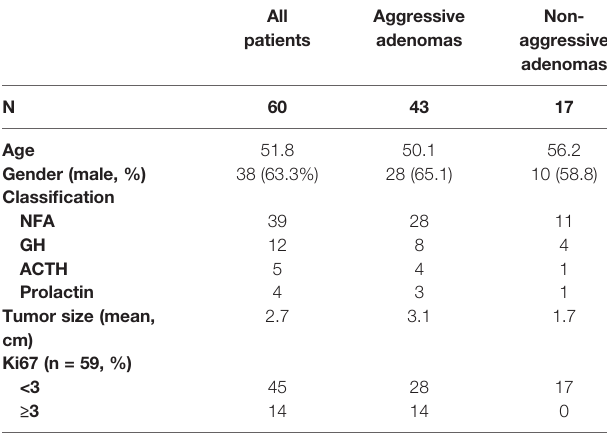
TABLE 1 | Clinical features of pituitary adenoma patients.